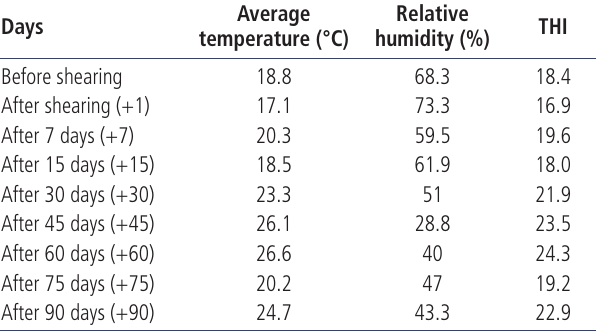
Average temperature (°C)